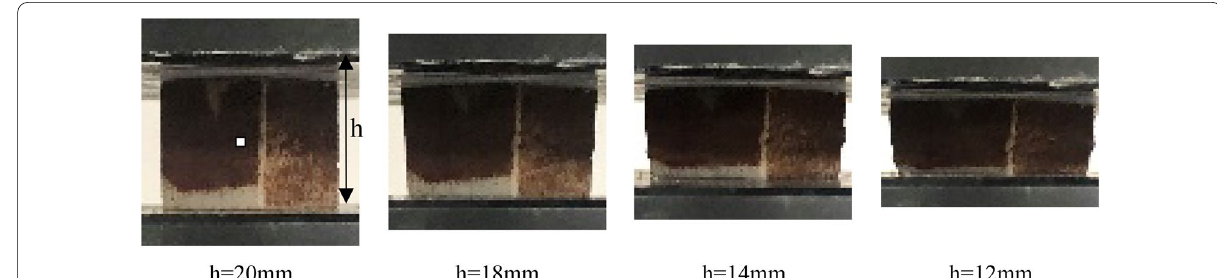
Fig. 8 Morphology of the powdered PCL cubic sample under the uniaxial compression test.